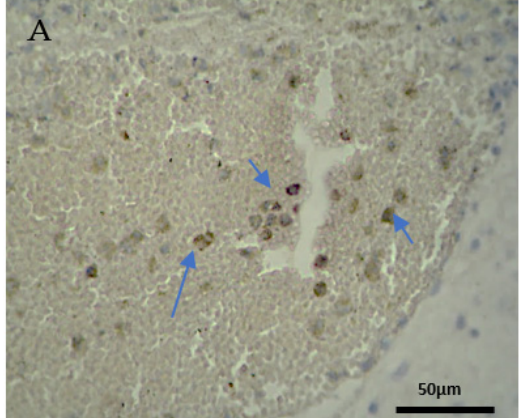
Figure 2. Evaluation of positive CD3 antigen expression. Control Group (CG): ( A ) there was no expression of CD3 in the DP (4 × 4 magnification). ( B ) There was moderate CD3 positive expression in the DB (4 × 4 magnification). ( C ) Decidua basalis and chorionic villi (4 × 10 magnification).